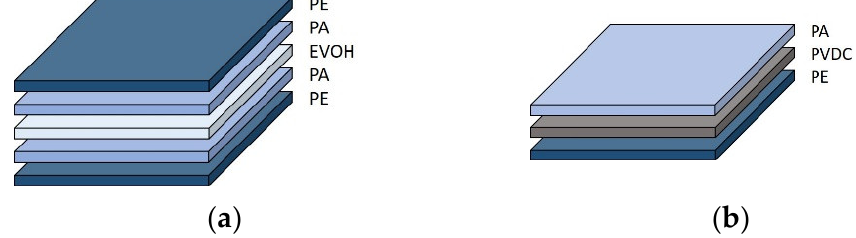
Figure 2. Two exemplary multilayer solutions for meat packaging: ( a ) 5-layered packaging solution and ( b ) 3-layered packaging solution. Abbreviations: PE (polyethylene), PA (polyamide), EVOH (ethylene vinyl alcohol), PVDC (polyvinylidene dichloride), PE (polyethylene). Figure adapted from the works in [15,87].